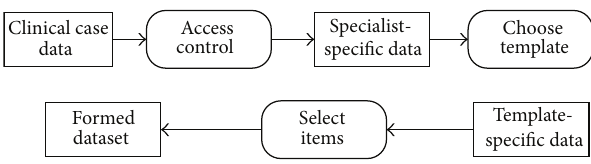
Figure 5: Data stream diagram of dataset